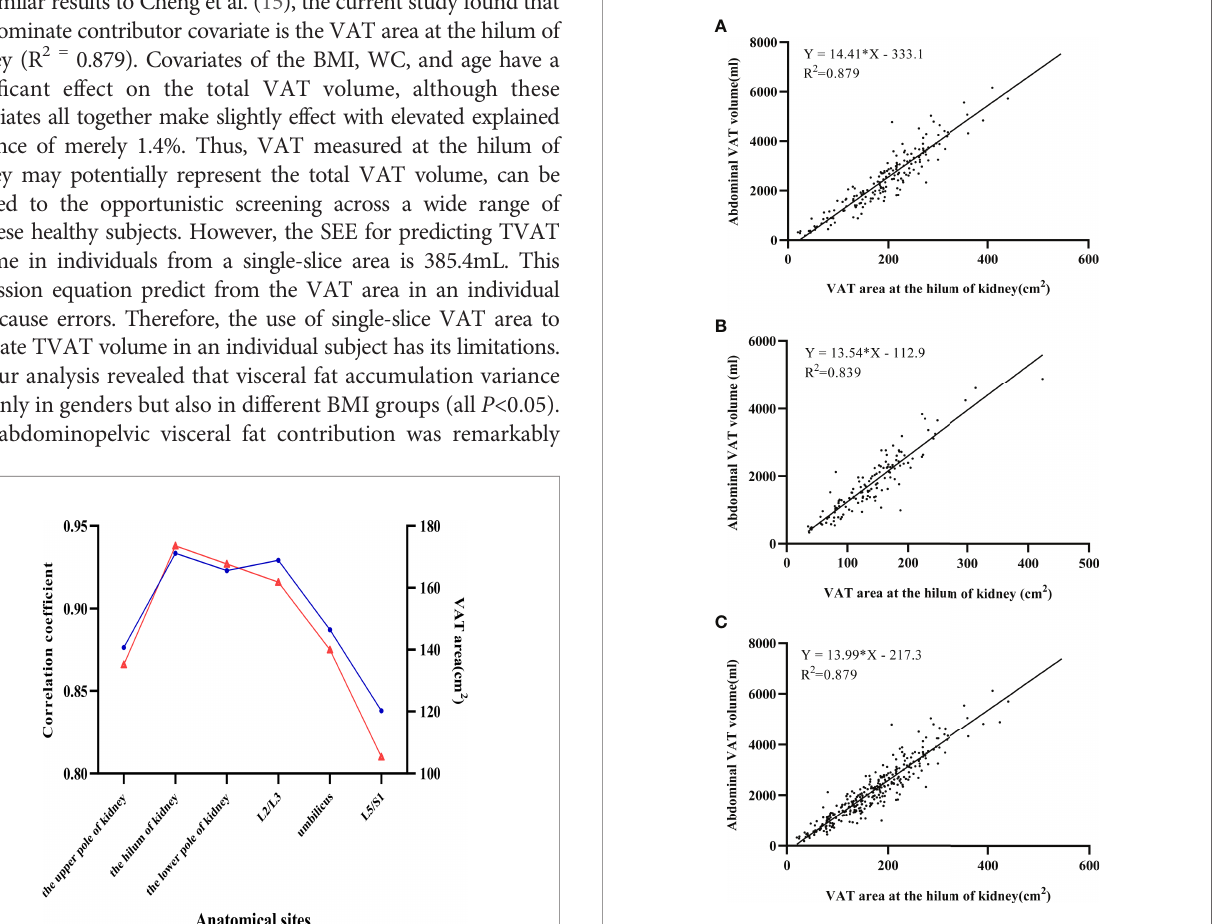
FIGURE 4 | Linear regression models between abdominopelvic visceral adipose tissue (VAT) volumes and VAT area at the hilum of kidney in men (A) and in women (B) and in all participants (C) . Both the coef fi cient for VAT area and the intercept of the equation are signi fi cant ( P < 0.001). Noted that both scatter plots were well fi tted in prediction equations (R 2 = 0.839-0.879).